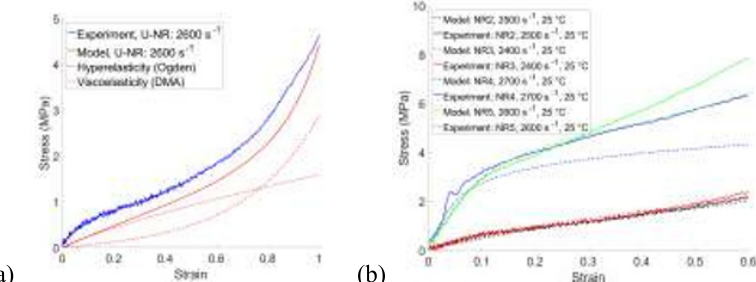
Figure 3. Comparing model predictions with experimental data for (a) unfilled natural rubber (U-NR) and (b) the four grades of filled particulate composites